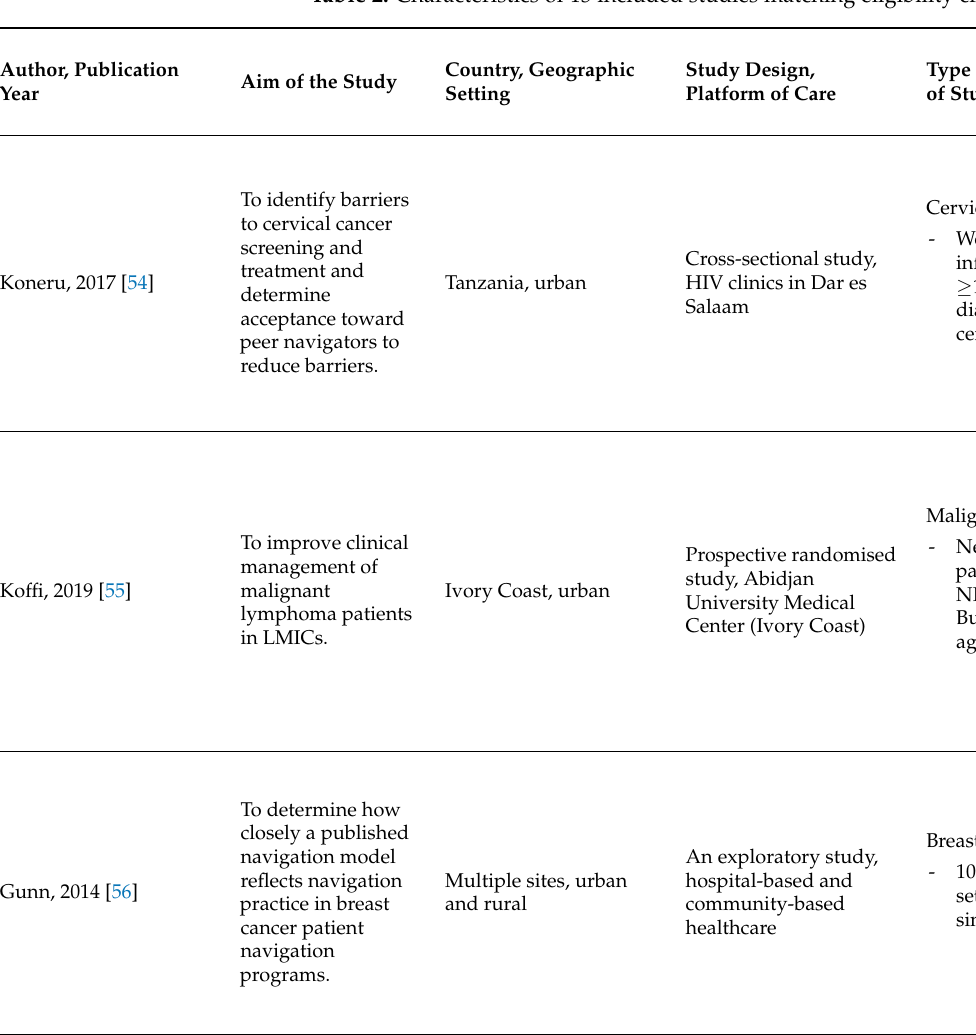
Table 2. Characteristics of 13 included studies matching eligibility criteria, presenting evidence on coordinated cancer care models identified across different